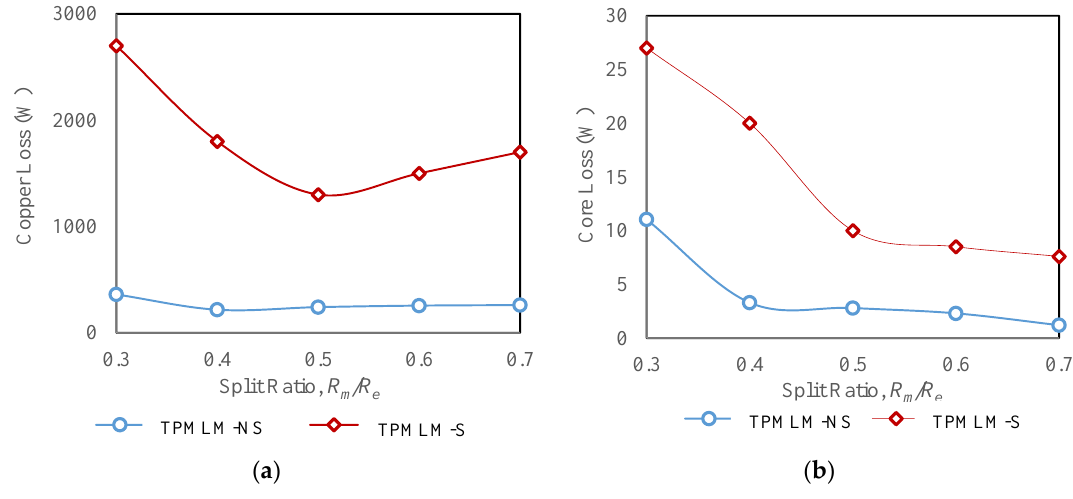
/ R m e on Losses ( a ) Copper Loss; ( b ) Core